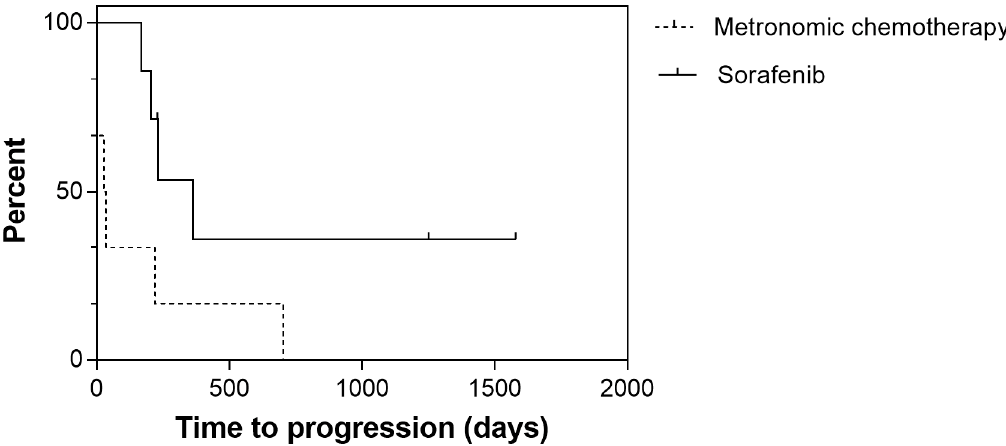
Figure 4. Time to progression for 13 dogs with hepatocellular carcinoma treated with sorafenib (solid line) or metronomic chemotherapy (dashed line). In the sorafenib group, dogs had a longer time to progression (363 versus 27 days; p = 0.044).